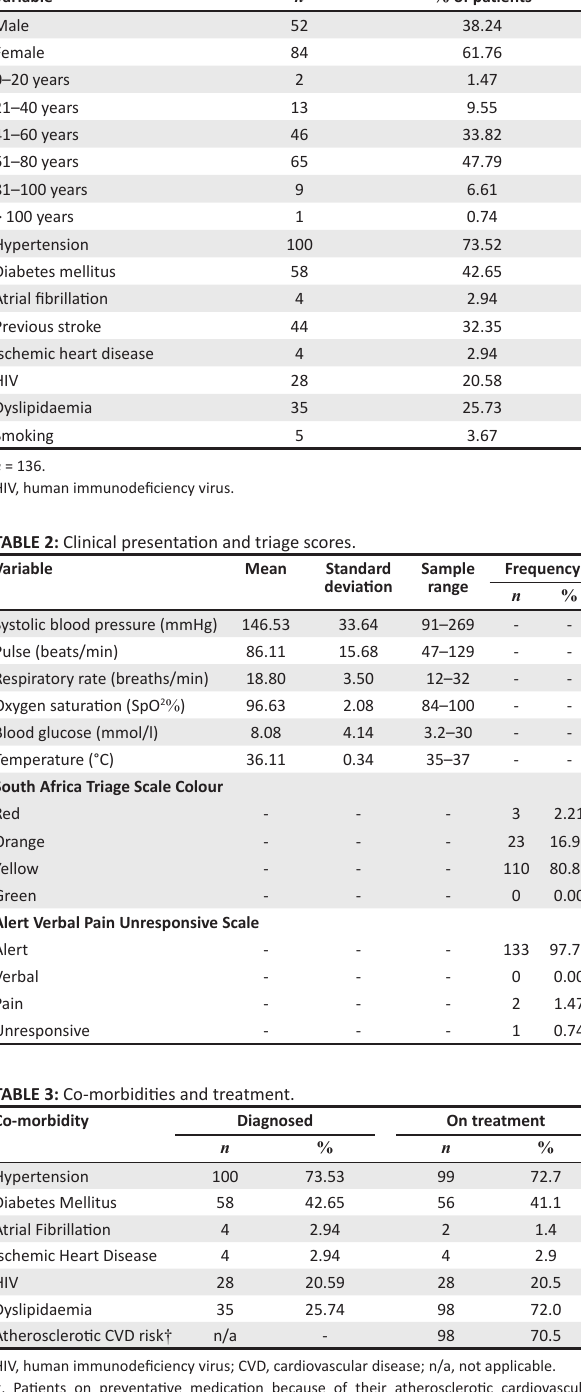
TABLE 1: Sample demographic data. Variable